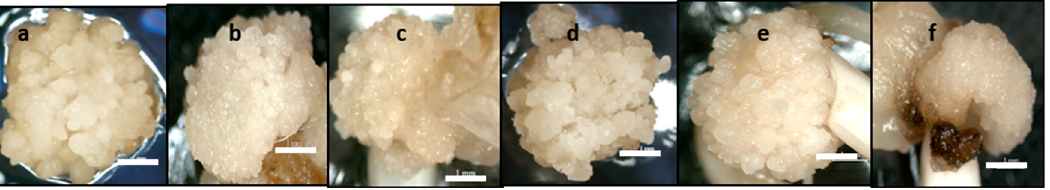
Figure 6. The morphology of calli MR220 ( a , b , c ) and MR220-CL2 ( d , e , f ) on MS media added with 3 mg/L of 2 and 4-D, 30 g/L of maltose and different concentration of sorbitol at ( a , d ): 10 g/L; ( b , e ): 20 g/L and, ( c , f ): 30 g/L after 3 weeks cultured (Bar = 1 mm).